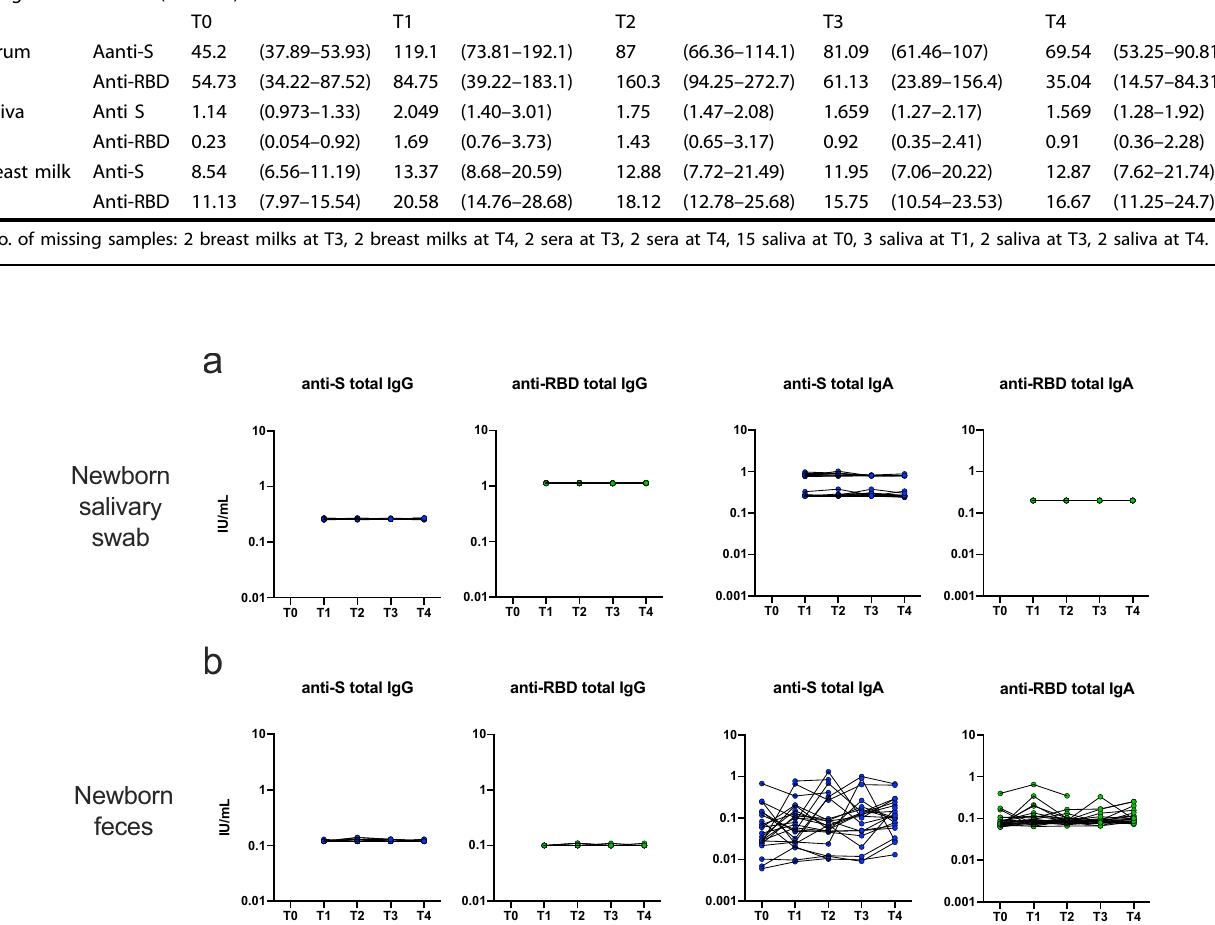
Fig. 3a, we could not demonstrate the presence of signi fi cant amounts of anti-SARS-CoV-2 antibodies on neonatal buccal mucosa, neither IgGs nor IgAs. In neonatal feces (Fig. 3b) we could retrieve only limited amounts of anti-S and anti-RBD IgA, which however did not signi fi cantly increase over time (T2 geometric mean: 0.08 IU/mL, 95% C.I.: 0.05 – 0.15 for anti-S; 0.09 IU/mL, 95% C.I.: 0.08 – 0.1 for anti-RBD). This indicated that mother- derived antibodies were not preserved in neonatal mucosal secretions.